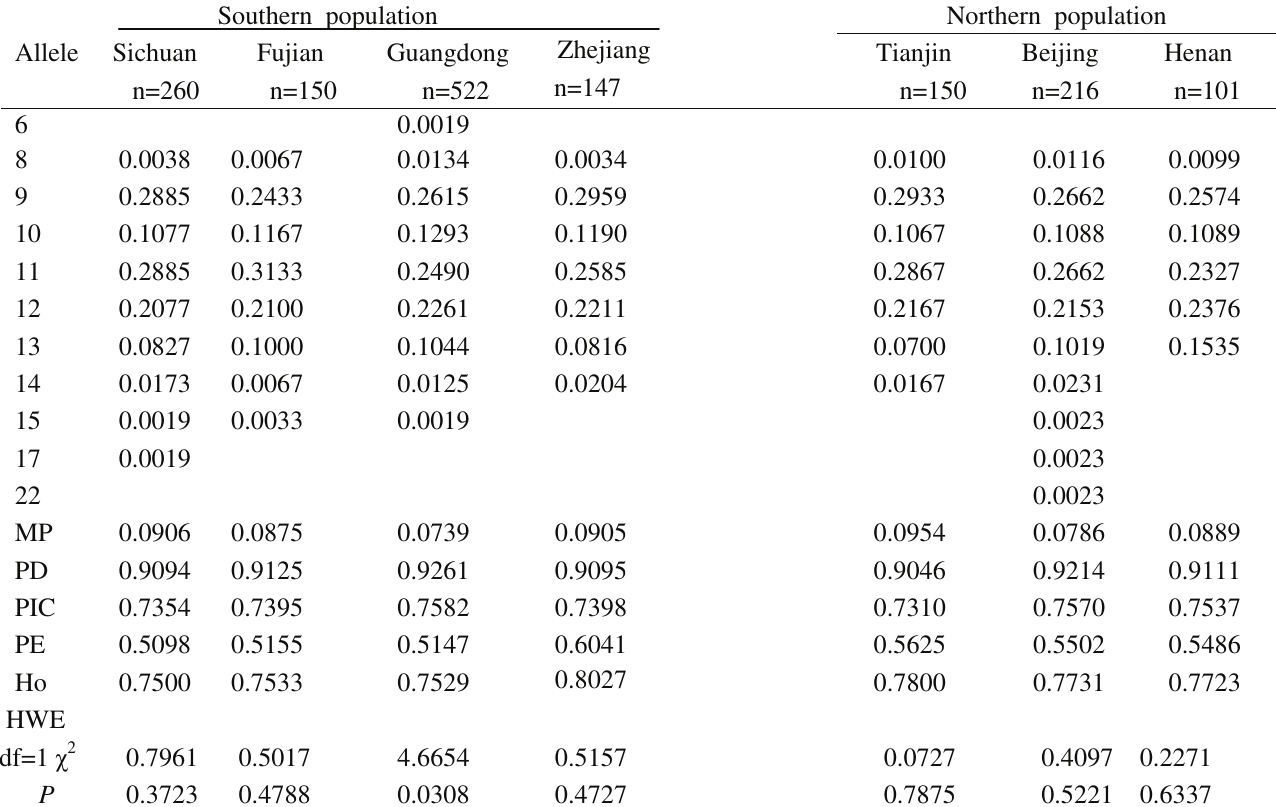
Table S2- Genetic polymorphism at the D16S539 locus for the seven Chinese population groups. Southern population Northern